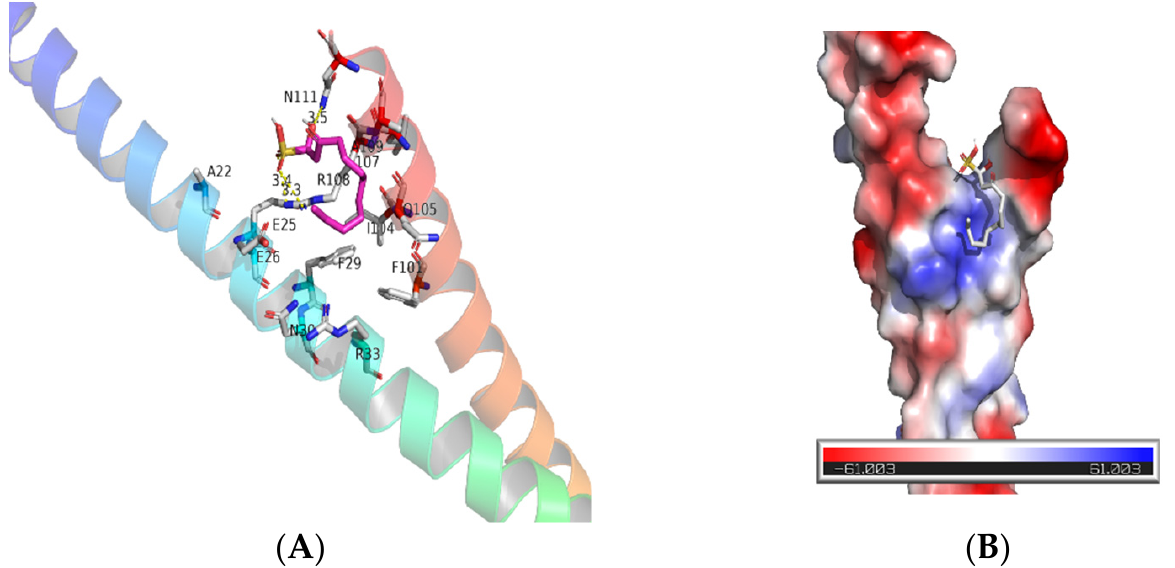
Figure 2. Molecular modeling of SNH binding to potential target FadA. ( A ) SNH interacts with the tail region of antiparallel α -helices of FadA (PDB: 3ETW) with the three potential hydrogen bonds shown in yellow dashed lines (distance labeled in Å). ( B ) Surface representation of FadA illustrating the SNH binding site. For clarity, of the interactions shown, only the protein segments that contain the groups of interest are shown. Hydrophobic, positively charged, and negatively charged surfaces are colored gray, blue, and red, respectively. FadA was shown in a rainbow cartoon from blue in N-terminus to Red in C-terminus. The residues around the binding groove of FadA and SNH are shown in sticks. N, O, and C atoms of side chains are colored blue, red and gray, respectively. SNH is in magenta. Molecular docking was carried out by Vina docking software, and the interactions between ligand and receptor were analyzed and presented by PyMOL.